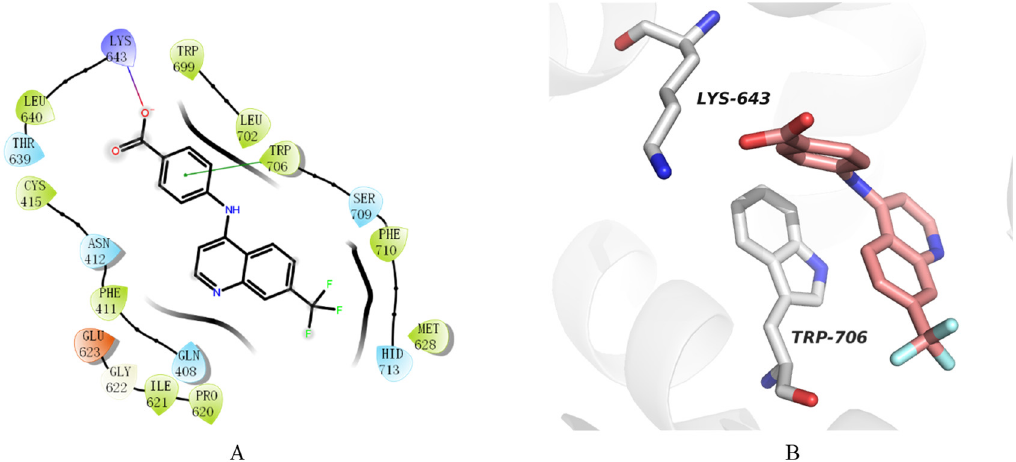
Figure 1. Docking model of 4-{[7-(trifluoromethyl)quinolin-4-yl]amino}benzoic acid in the active site of RNA polymerase (PDB ID: 3CM8). ( A ) The two-dimensional (2D) diagrams of the interactions between 4-{[7-(trifluoromethyl)quinolin-4-yl]amino}benzoic acid and 3CM8. The Pi-Pi stacking interactions with residues were represented by a green line segment. The salt bridge interactions with residues were represented by the red and purple line. ( B ) The three-dimensional (3D) diagrams of the interactions between 4-{[7-(trifluoromethyl)quinolin-4-yl]amino}benzoic acid and 3CM8.